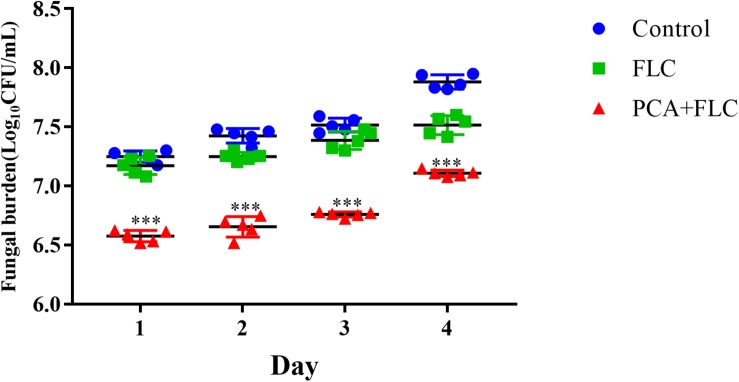
Fungal burden of Galleria mellonella infected with Candida albicans. The concentration of yeast cells was 5 × 108 CFU/larva. Treatments consisted of PBS, fluconazole (FLC) (160 μg/ml), PCA (40 μg/ml), and a combination of FLC (160 μg/ml) with PCA (40 μg/ml). Data came from the means of three independent experiments. For clarity, data for treatment with PCA are not shown because the data obtained closely followed those shown for the control group. The data came from the means of three independent experiments. ∗∗∗P < 0.001.